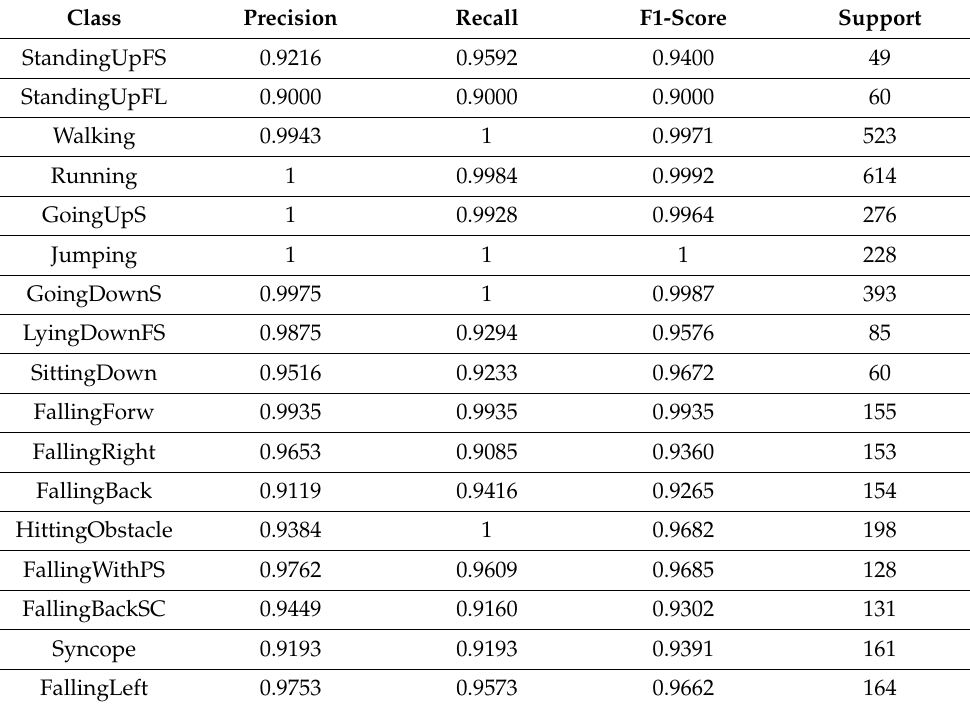
Table A1. CNN1—Subject-dependent detailed performance macro